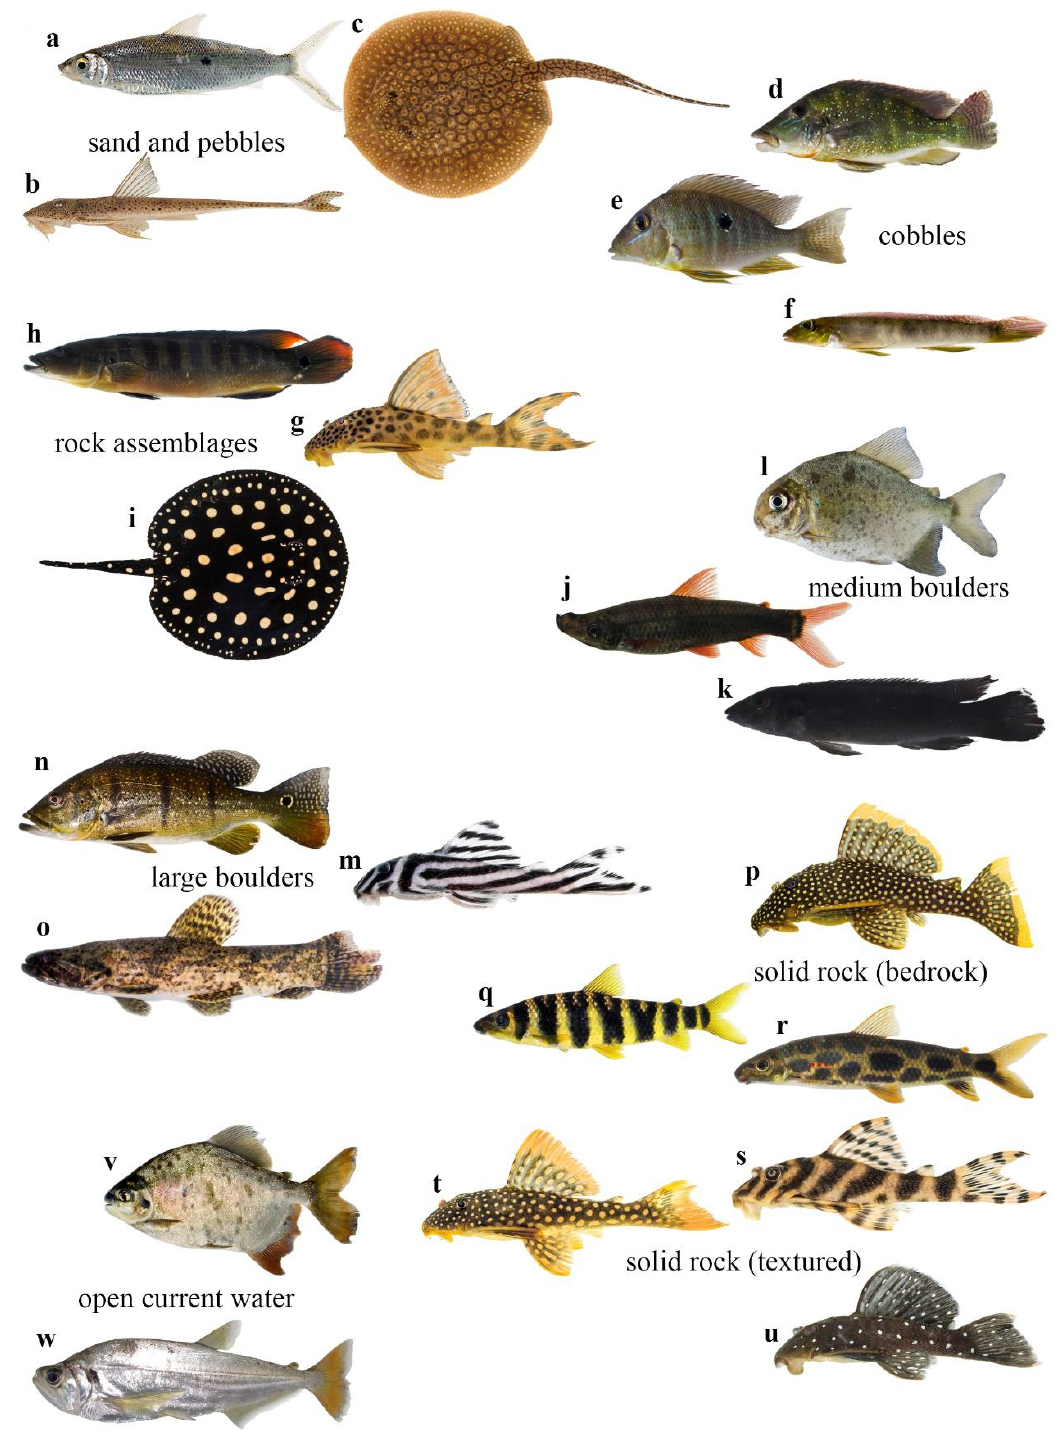
Figure 4. Example of morphological diversity commonly associated with the habitat classes in the Xingu River basin. ( a ) Hemiodus unimaculatus , ( b ) Pseudoloricaria laeviscula , ( c ) Potamotrygon orbigny , ( d ) Retroculus xinguensis , ( e ) Geophagus argyrostictus , ( f ) Teleocichla monogramma , ( g ) Peckoltia sabaji , ( h ) Crenicichla sp. ‘ xingu 1 ’, ( i ) Potamotrygon leopoldi , ( j ) Sartor respectus , ( k ) Teleocichla preta , ( l ) Ossubtus xinguensis , ( m ) Hypancistrus zebra , ( n ) Cichla melaniae , ( o ) Hoplias aimara , ( p ) Baryancistrus xanthellus , ( q ) Leporinus tigrinus , ( r ) Hypomasticus julii , ( s ) Peckoltia vittata , ( t ) Scobinancistrus aureatus , ( u ) Spectracanthicus punctatissimus , ( v ) Tometes kranponhah , ( w ) Hydrolycus tatauaia . Photographs are not to scale.